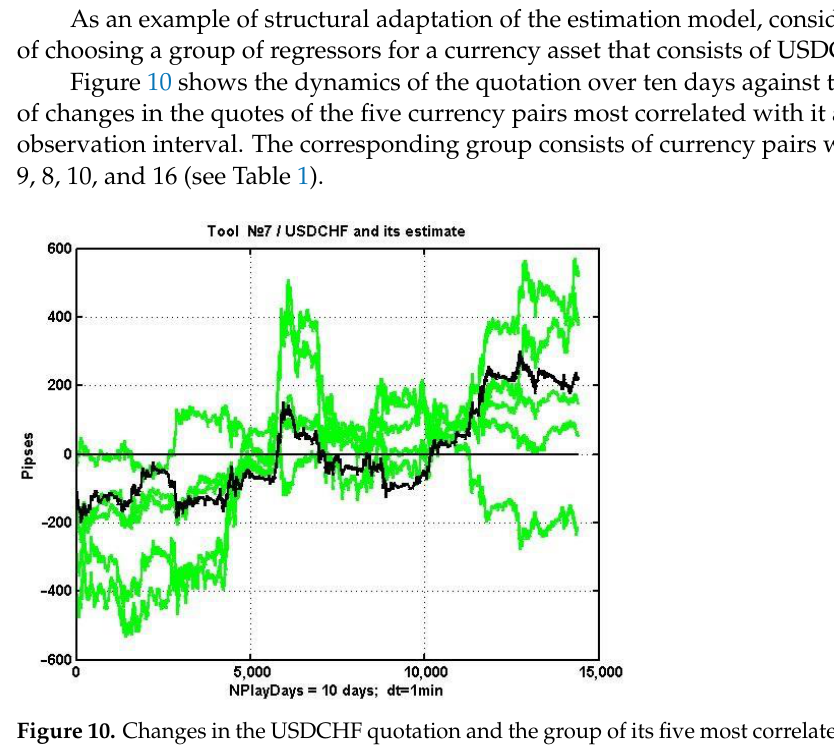
Table 2. Lists of regressors in descending order of correlation on 10-h non-overlapping observation